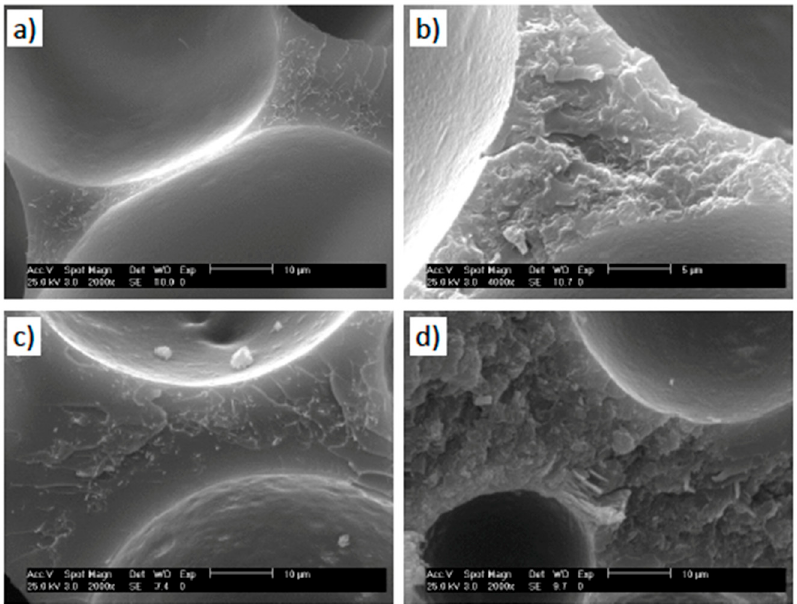
Figure 5. High magnification SEM images of the foams. ( a ) 0.5 wt.% MWCNT-LD, ( b ) 1.5 wt.% TRGO-LD, ( c ) 0.5 wt.% MWCNT-HD, and ( d ) 1.5 wt.%